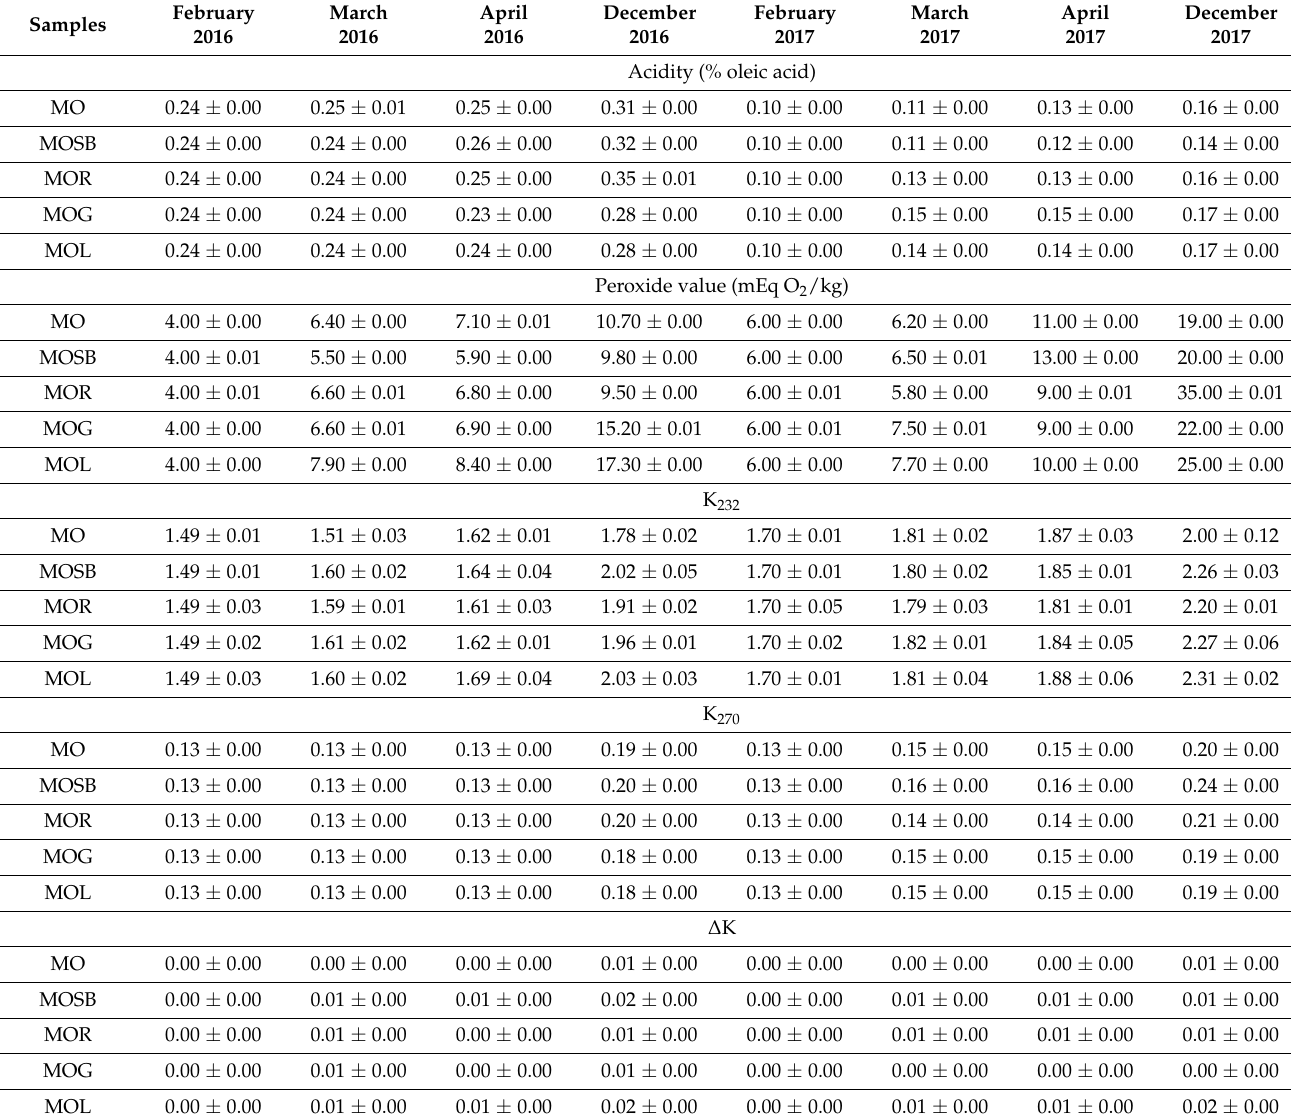
Table 2. Quality parameters of all olive